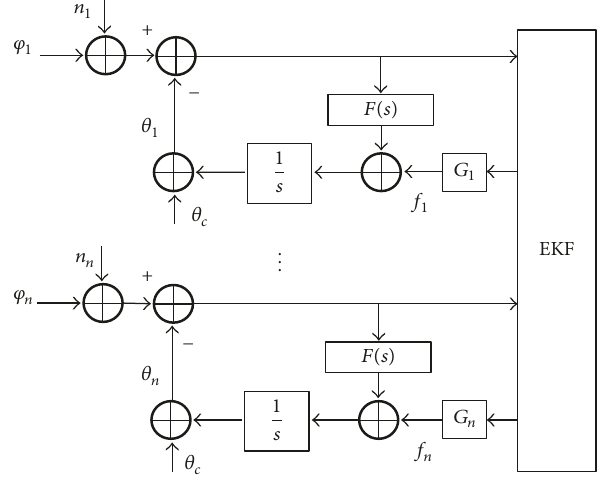
Figure 2: Transfer function models of the joint VPLL